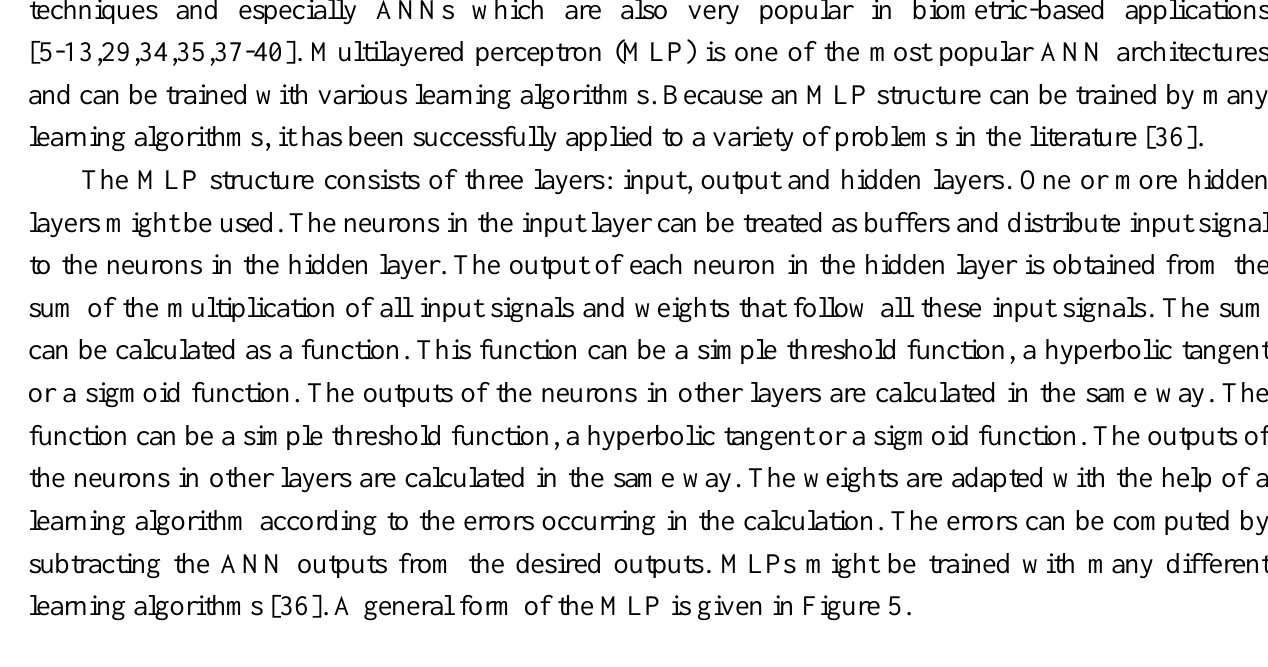
Figure 5. General Form of the